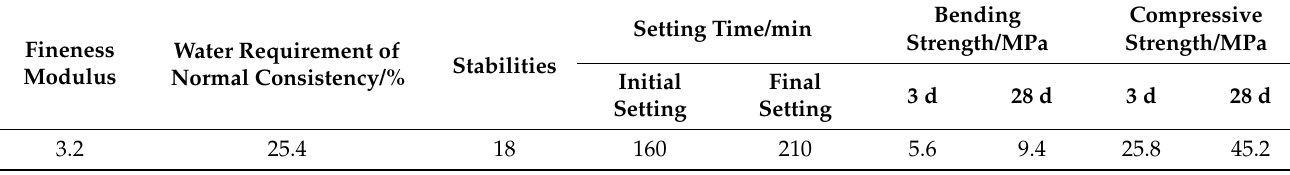
Table 1. Material property of cement.